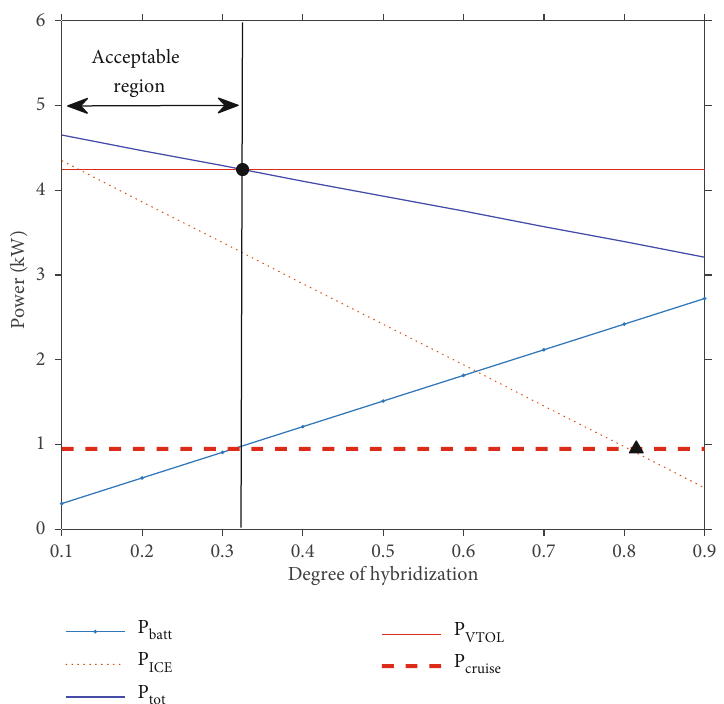
Figure 10: Acceptable region of γ ( payload = 10 ).